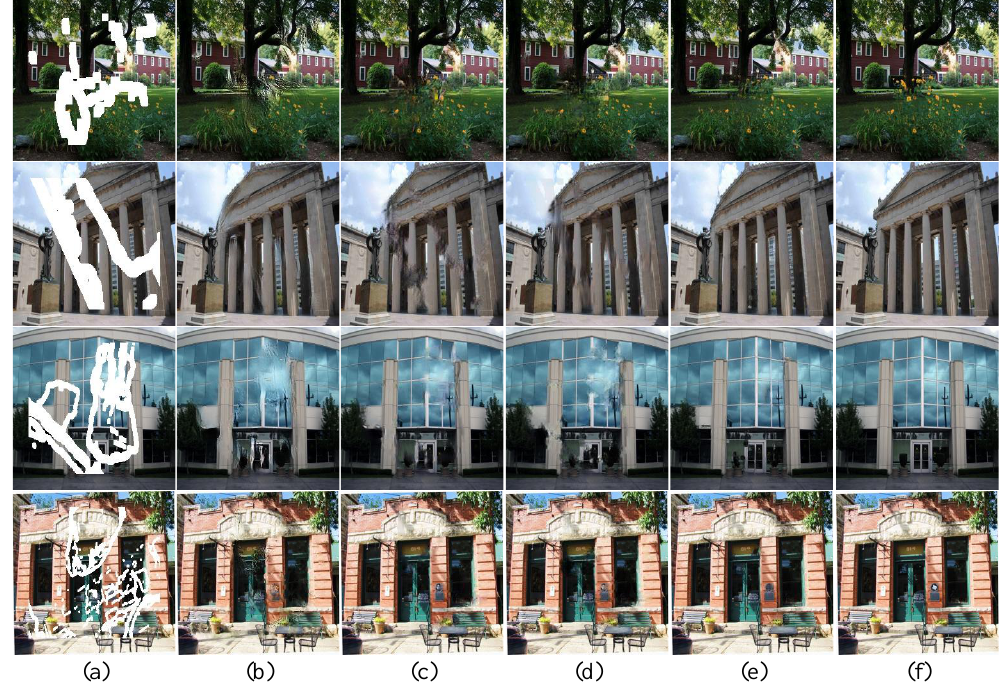
Figure 5. Comparison on the Places2 dataset. ( a ) Input images. ( b ) GC [13]. ( c ) EC [8]. ( d ) MED [6]. ( e ) Ours. ( f ) Ground